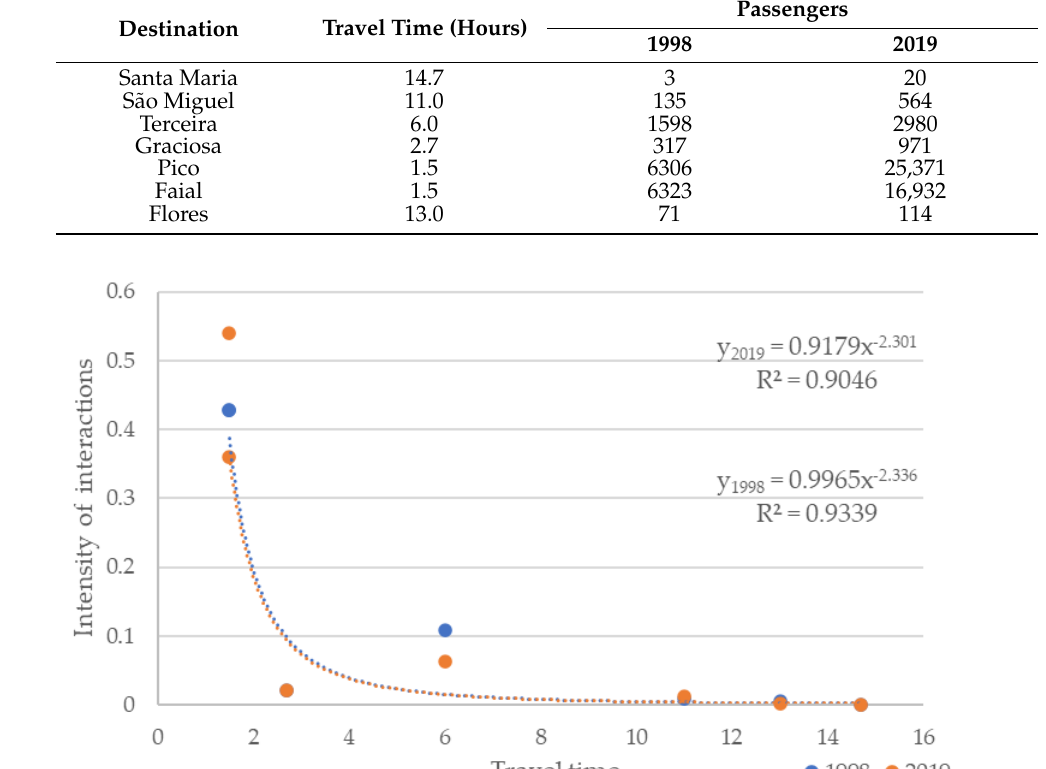
Figure 4. Intensity of interactions and travel time to São Jorge Island from the rest of the archipelago — for 1998 and 2019.